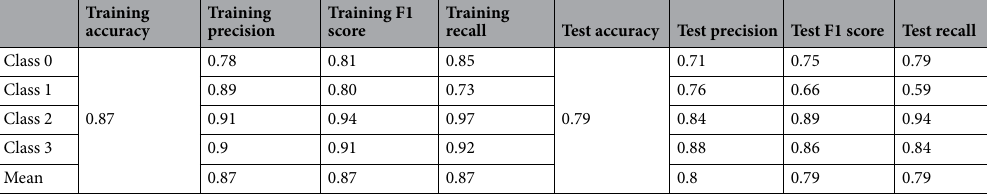
Table 2. Selected Model